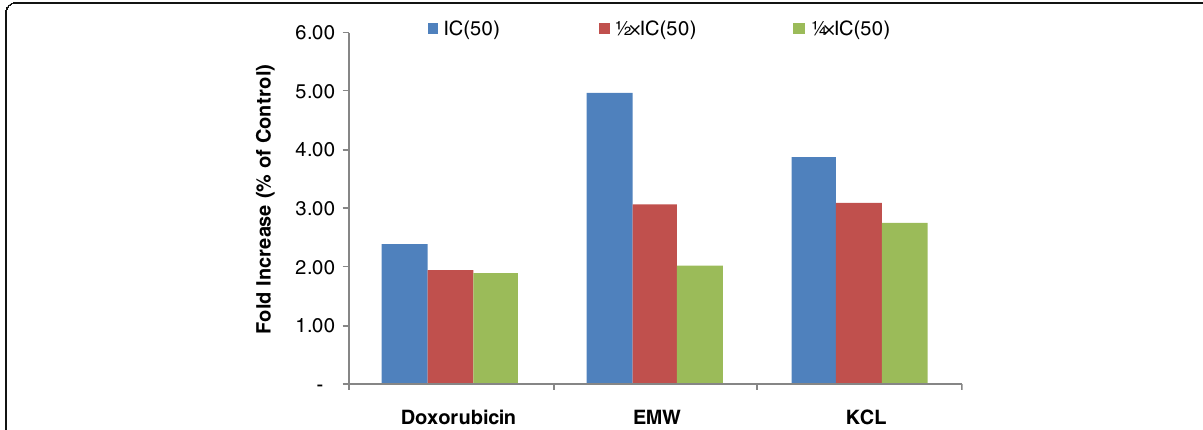
Fig. 3 Effects of Elephantopus mollis whole plant (EMW) and Kalanchoe crenata leaves (KCL) extracts and doxorubicin for 24 h in ROS production in MCF-7 cells after treatment with. IC 50 values were 3.97 μ g/mL (EMW), 19.31 μ g/mL (KCL) and 0.32 μ g/mL